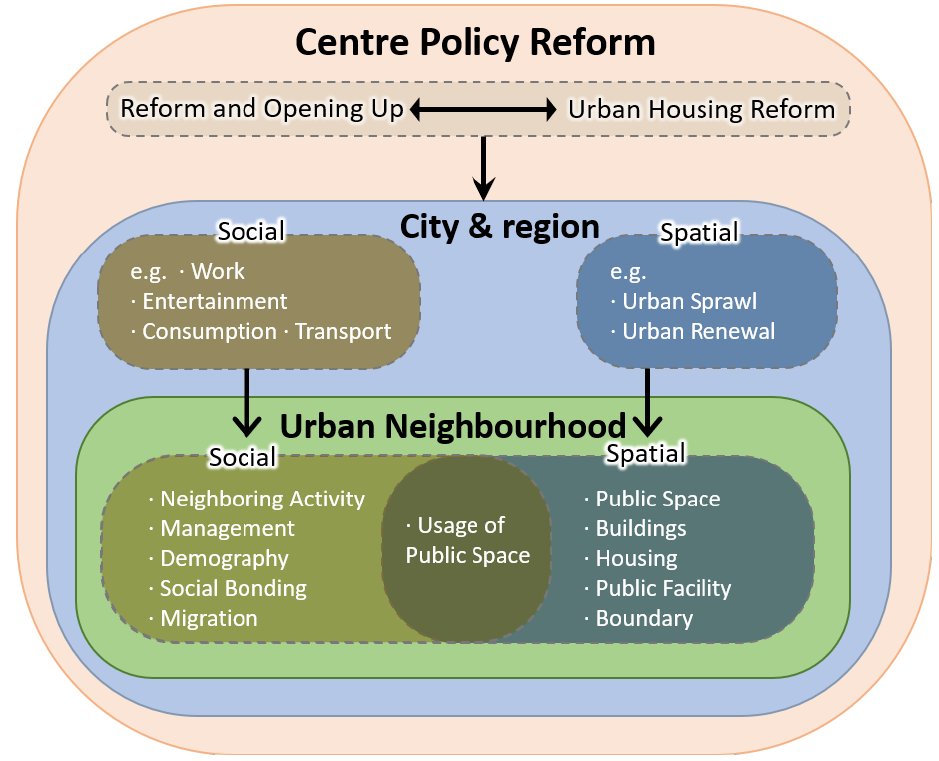
Figure 1. Frame of socio-spatial changes: elements and impact transmission at different